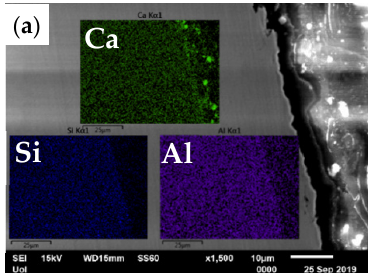
Figure 3. SEM images (cross-sections) of 316L rebars removed from concrete with Inhibitor B and ( a ) 0% FA, ( b ) 20% FA, and ( c ) 25% FA, after a salt fog test for a period of 4 months.